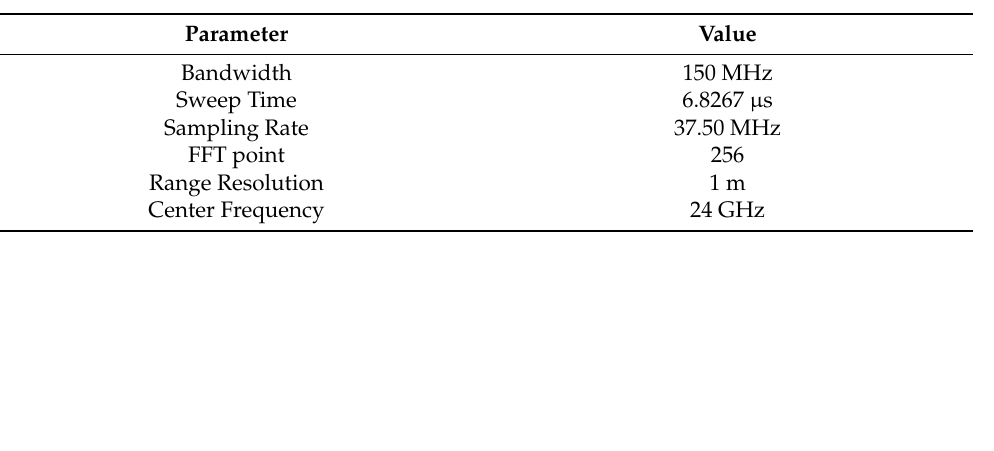
Table 8. FMCW RADAR physical